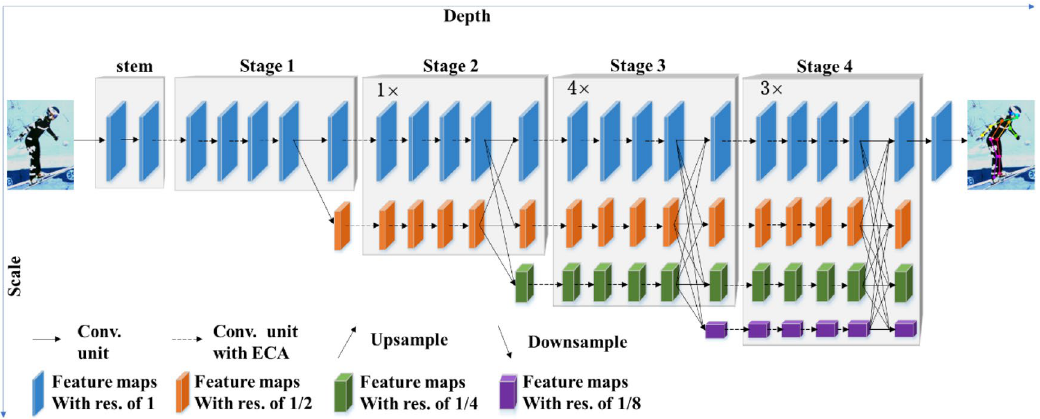
Figure 5. Architecture of